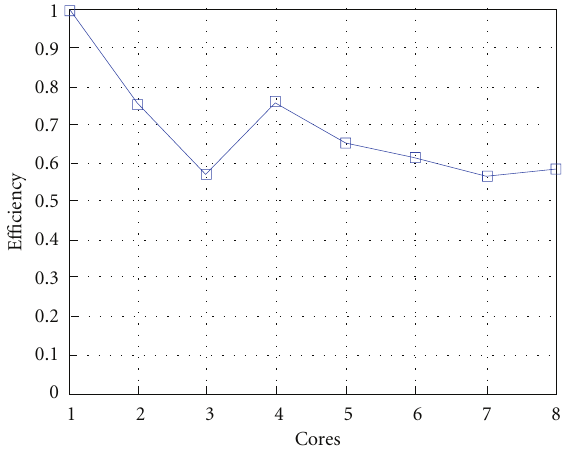
Figure 23: Test 2: Algorithm SI: E ffi ciency. Δ τ I = 0 . 16.